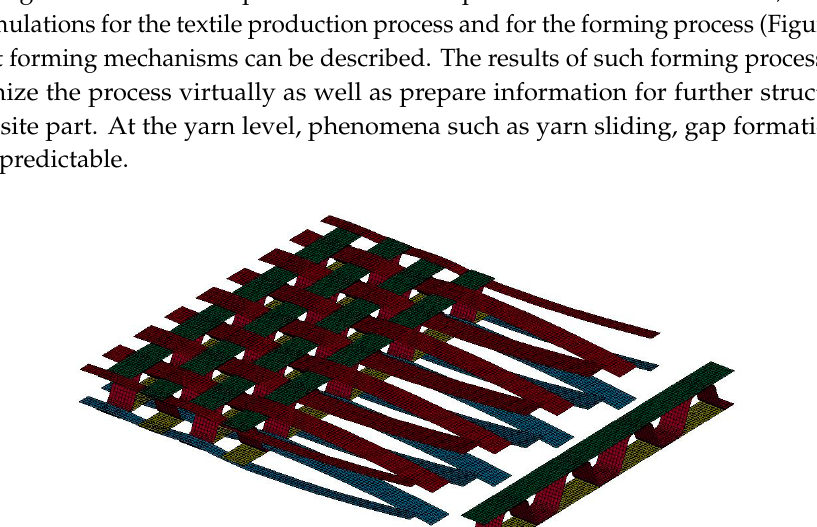
Figure 2. Weaving simulation of a 3D multilayers woven fabric from fiber roving, which are represented by shell elements.